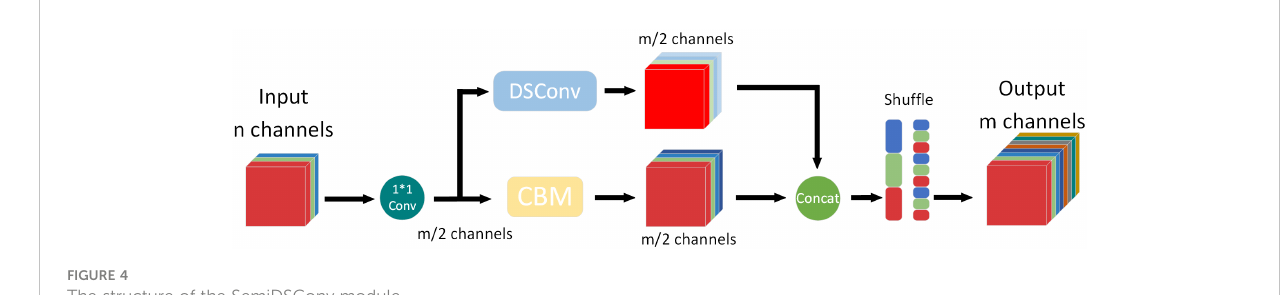
FIGURE 4 The structure of the SemiDSConv